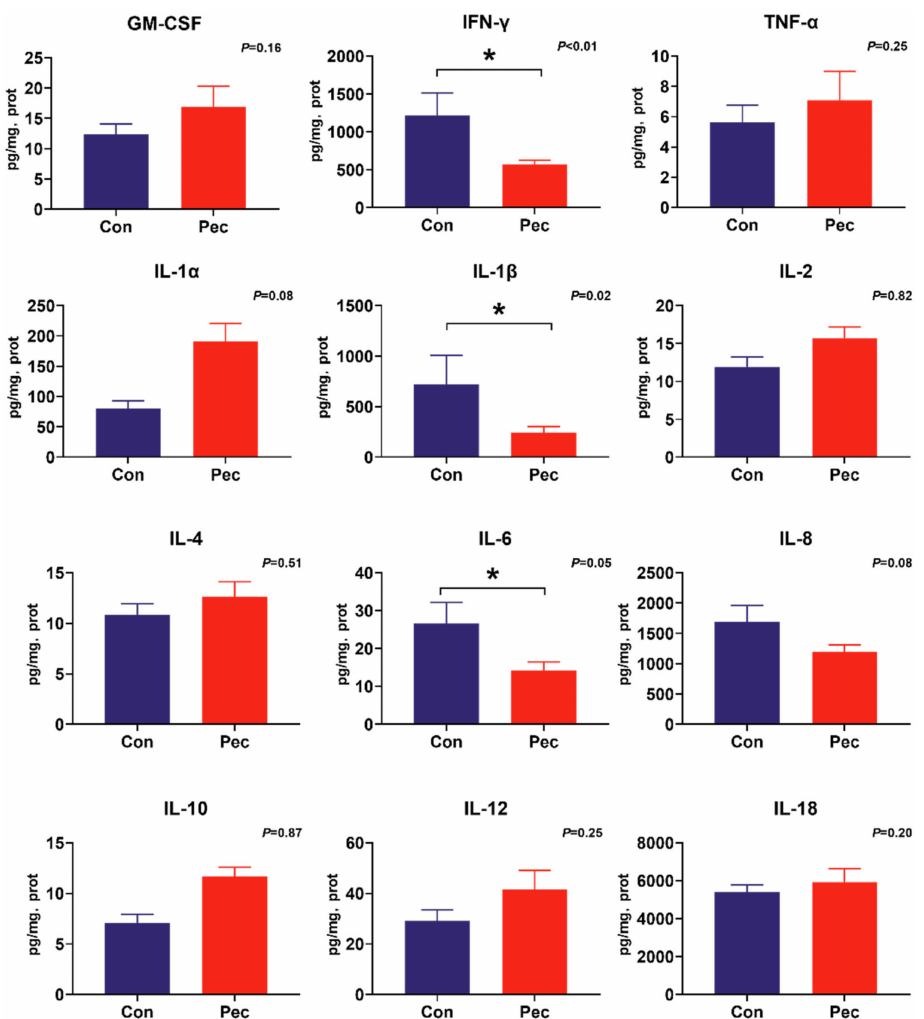
Figure 5. The concentration of cytokine in cecal mucosa of pigs fed either the control or pectin diet. Values are means ( n = 6 / diet), with their standard errors represented by vertical bars. * Means statistically significant ( p ≤ 0 ·